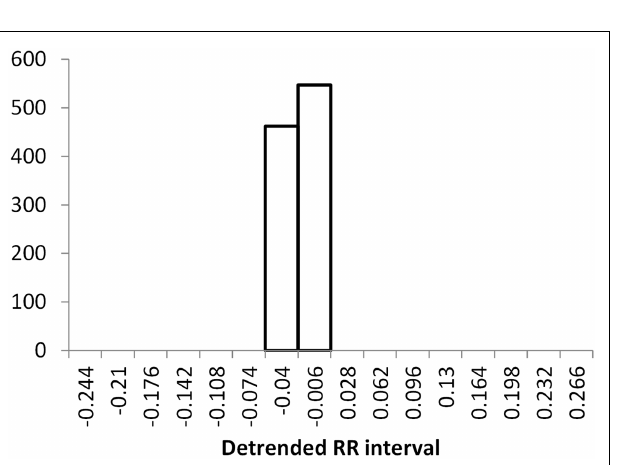
FIGURE 4 | Histograms of the detrended RR intervals for participants in the Definite CAN group made using the same bin divisions for all data used .The vertical axis shows the count of RR intervals falling into each bin. The SD is 0.026.